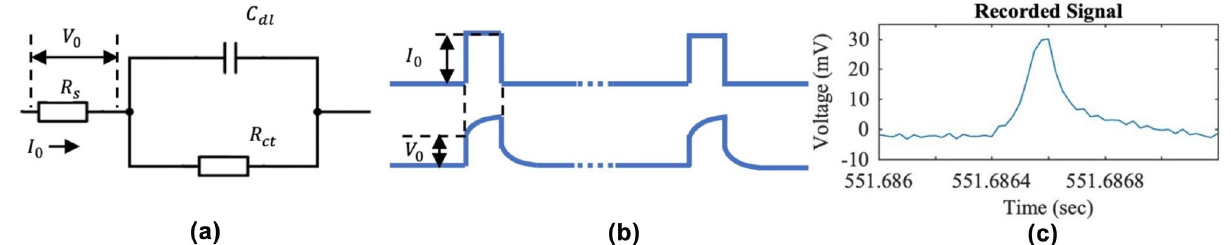
Figure 2. Bio-impedance mechanism. ( a ) Randles Cell Model. R s reflects the colonic tissue impedance after stimulation. ( b ) Electrode overpotential resulted from a stimulus with small intensity. ( c ) Representative recorded